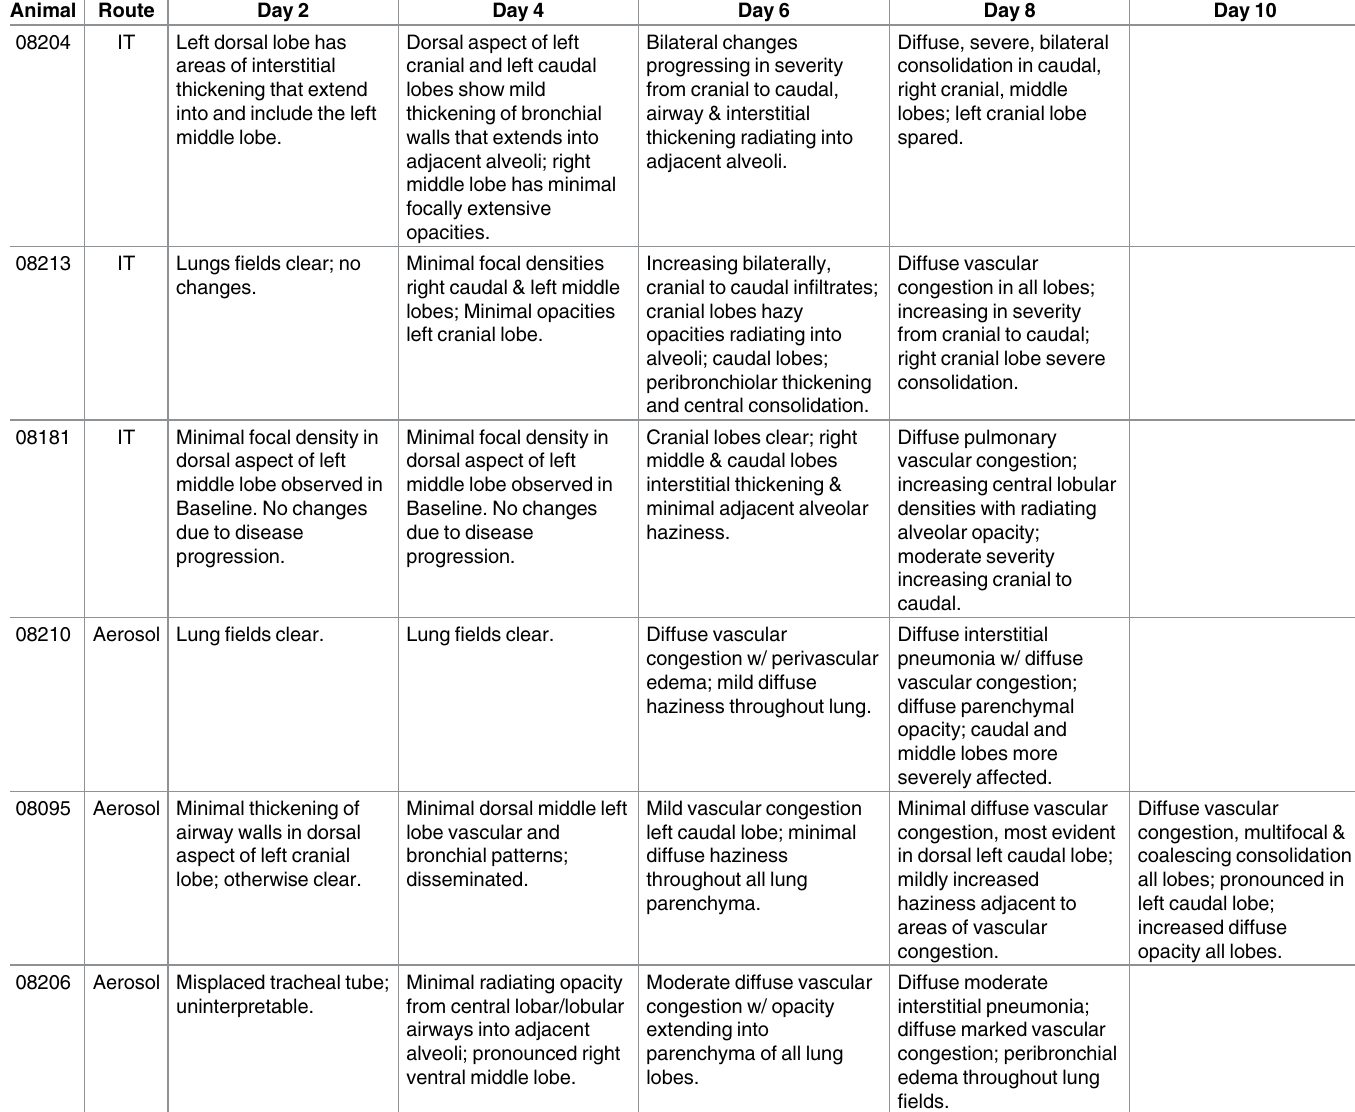
Table 1. Radiographic findings in lungs of African green monkeys inoculated with Nipah virus between 2 and 10 days post infection. Imagingand clinicalobservationwere made every two days until the animal met euthanasia criteria. Animal